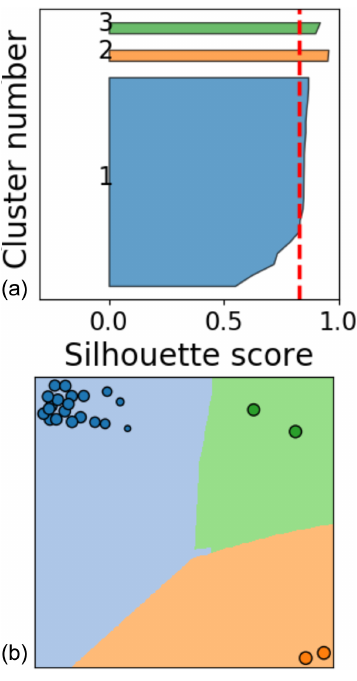
Figure 20. (a) Silhouette samples per cluster. (b) MDS representa- tion. Data from towing-tank surge experiment.